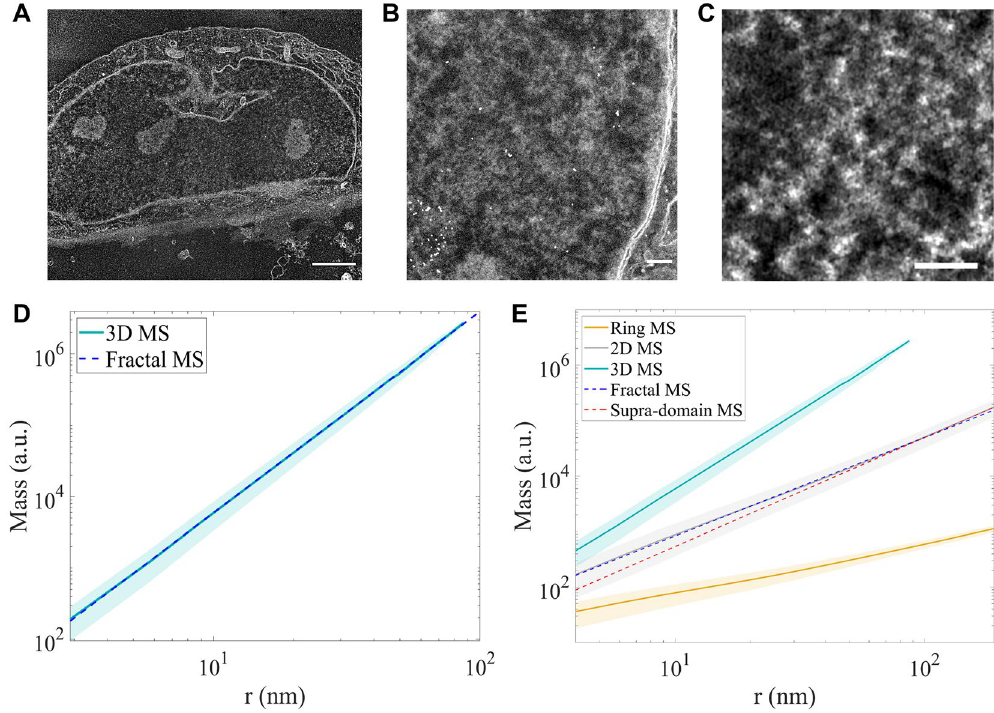
Figure 2. Chromatin folds into packing domains that have similar mass scaling behavior. ( A ) STEM HAADF image of a 150 nm section of a BJ cell nucleus for tomography reconstruction. Scale bar: 2 µm. ( B ) A magnified view of the chromatin and the nuclear periphery of the same cell in ( A ) with gold fiducial markers (white). The intensity variation of the image shows that the chromatin packs at different densities throughout. Scale bar: 200 nm. ( C ) A virtual 2D slice of the chromatin of a BJ cell after tomography reconstruction. Scale bar: 100 nm. The mass scaling analysis was performed on the gray scale tomograms ( D , E ) The average mass scaling (MS) curves from the analysis of four A549 cells in ( D ) 3D and ( E ) Ring, 2D, and 3D. The mass scaling was conducted for the entire grayscale tomogram and the average mass scaling curves weighted by the chromatin density values were computed. 3D mass scaling curve exhibits power-law behavior with a single scaling exponent up to r = 60 nm. Two regimes of mass scaling with different packing scaling D can be identified. In the 2D cases, the MS curve starts with a packing scaling with D log < 3 (blue dashed line) and smoothly transitions to values close to D log = 3 (red dashed